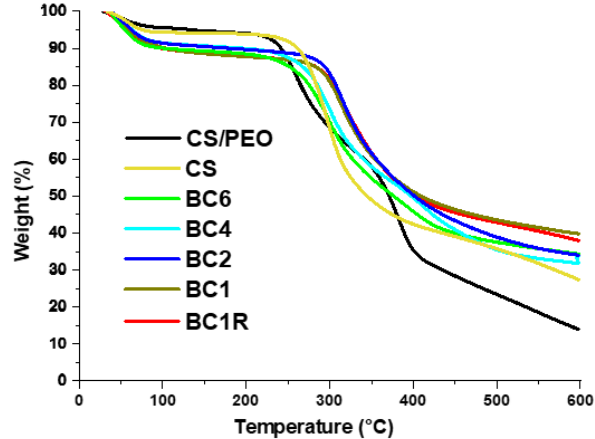
Figure 6. TGA curves of the chitosan-based nanofibers.